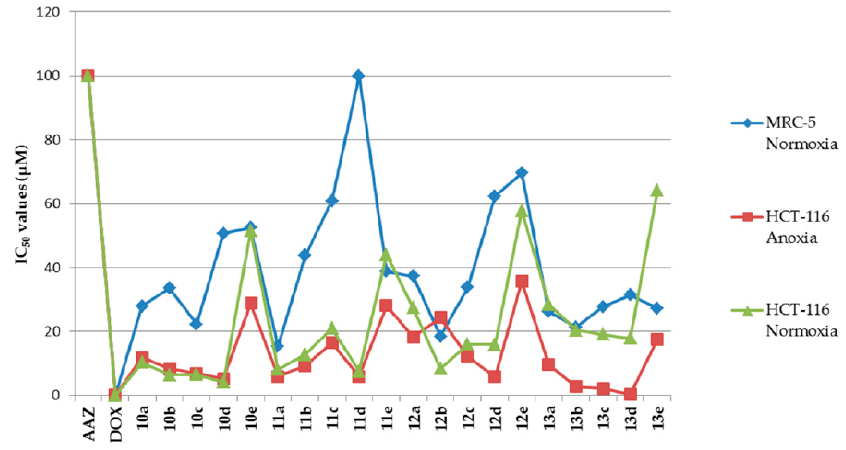
Figure 2. The line chart of the IC 50 values of tested compounds against MRC-5 and MDA-MB-231. Molecules 2016 , 21 , 758